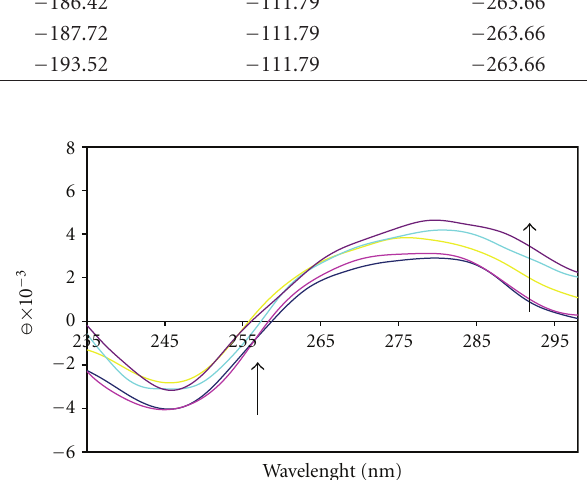
Figure 7: Circular dichroism spectra of CT DNA (5 × 10 − 5 M) in Tris-HCl (10mM), in the presence of increasing amounts of the complex at the following stoichiometric ratios: r i = [com- plex]/[DNA] = 0.0, 0.2, 0.4, 0.6, and 0.8.